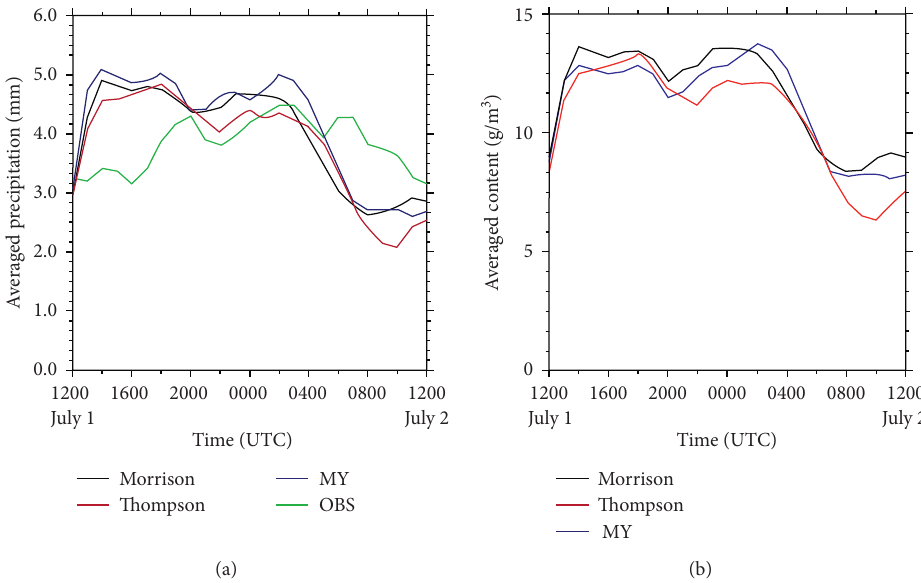
Figure 6: Time series of (a) area-averaged rainfall and (b) rainwater content in a heavy rainfall area of observation and simulation results from 1200 UTC on 1 July to 1200 UTC on 2 July